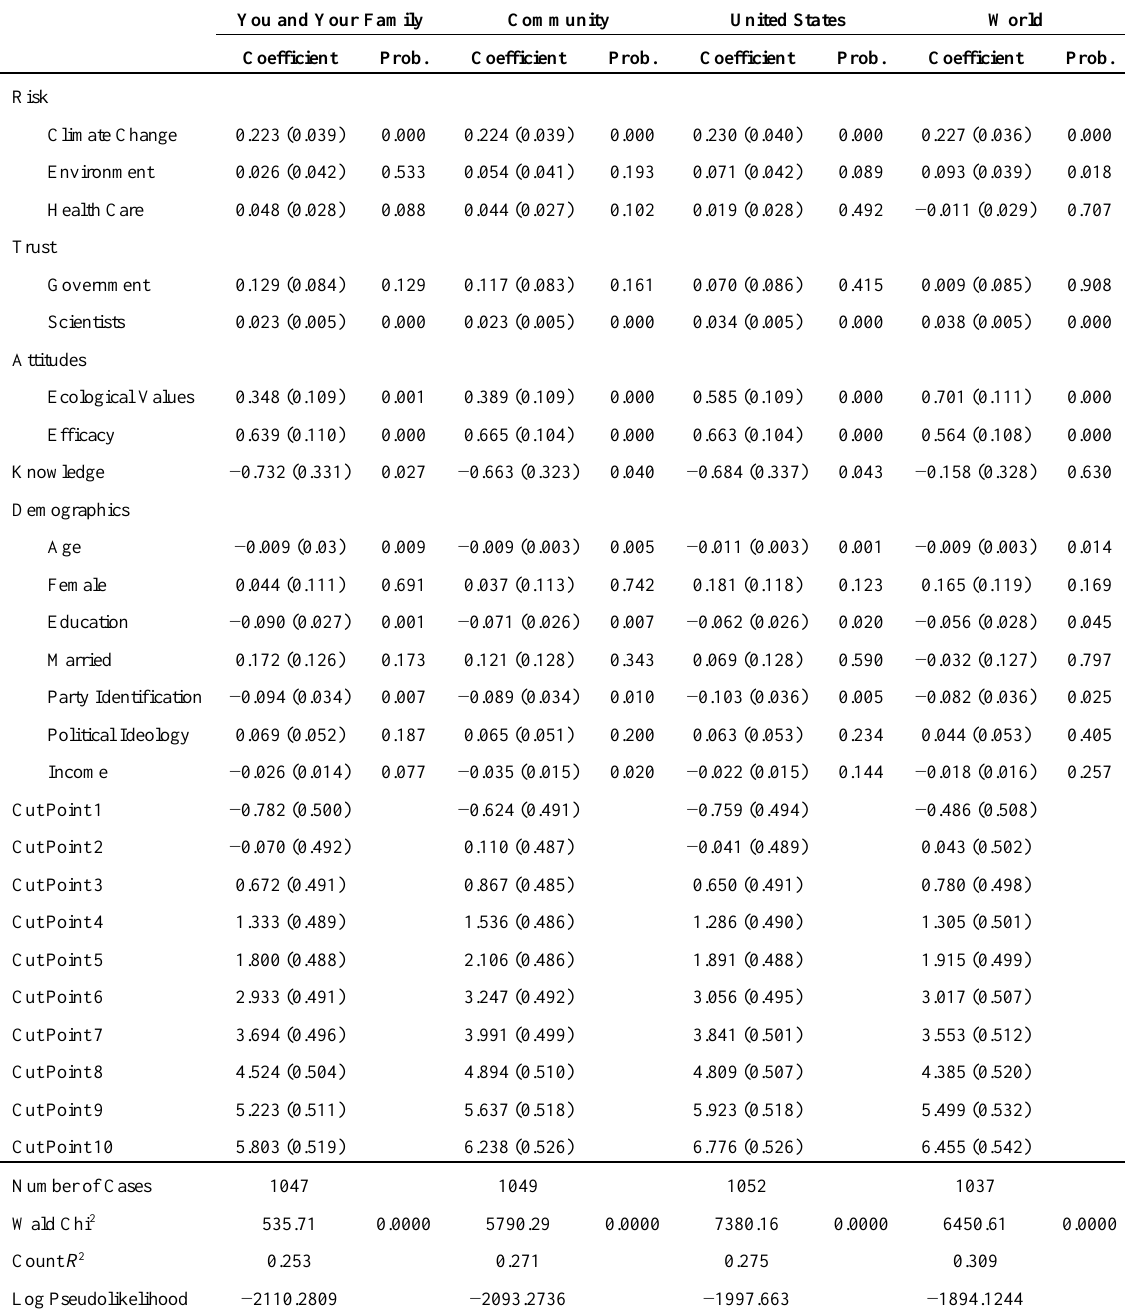
Table 2. Determinants of the Health Risk caused by Climate Change by Geographical Group. You and Your Family Community United States World Coefficient Prob. Coefficient Prob. Coefficient Prob. Coefficient